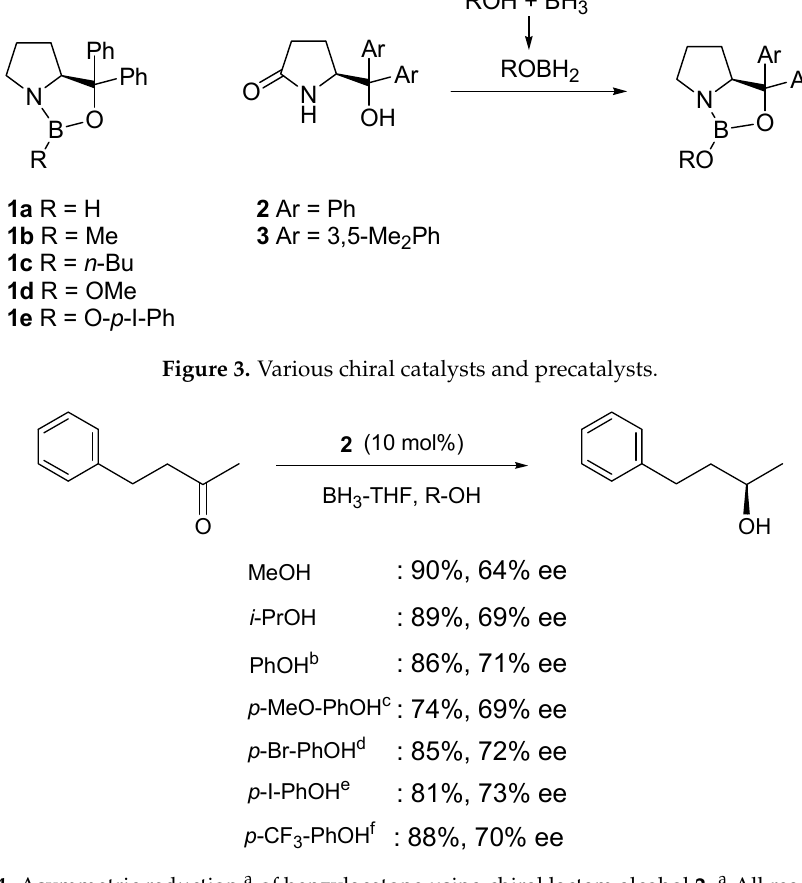
Scheme 4. Asymmetric reduction a of benzylacetone using chiral lactam alcohol 2 . a All reactions were carried out with 10 mol% of 2 and 1.2 equiv of BH 3 and ROH in THF at room temperature. b p K a 9.99.